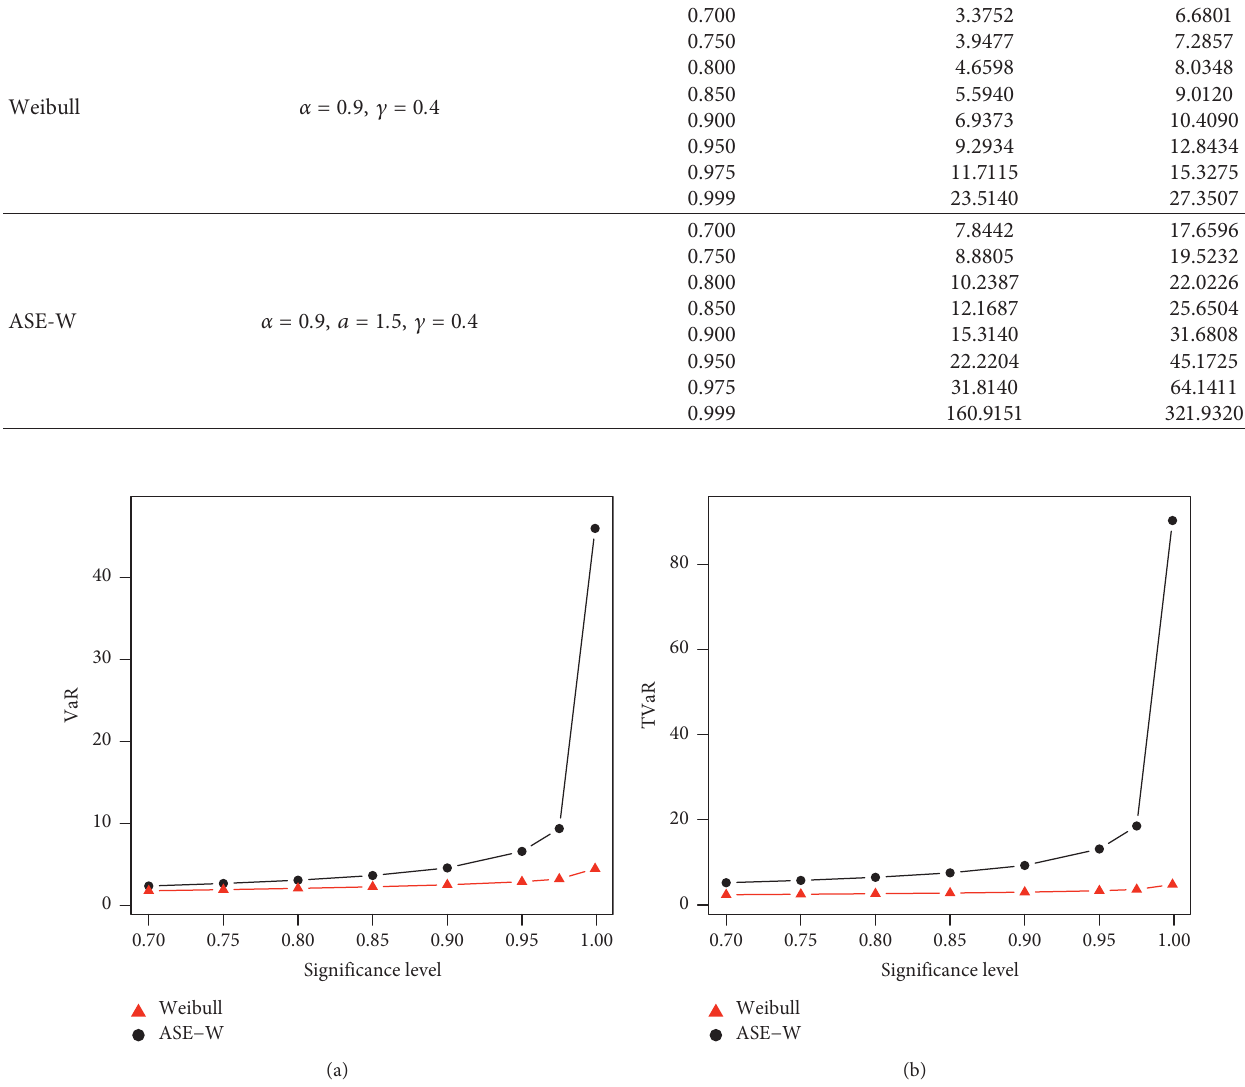
Figure 6: Graphical sketching of the VaR and TVaR using the results in Table